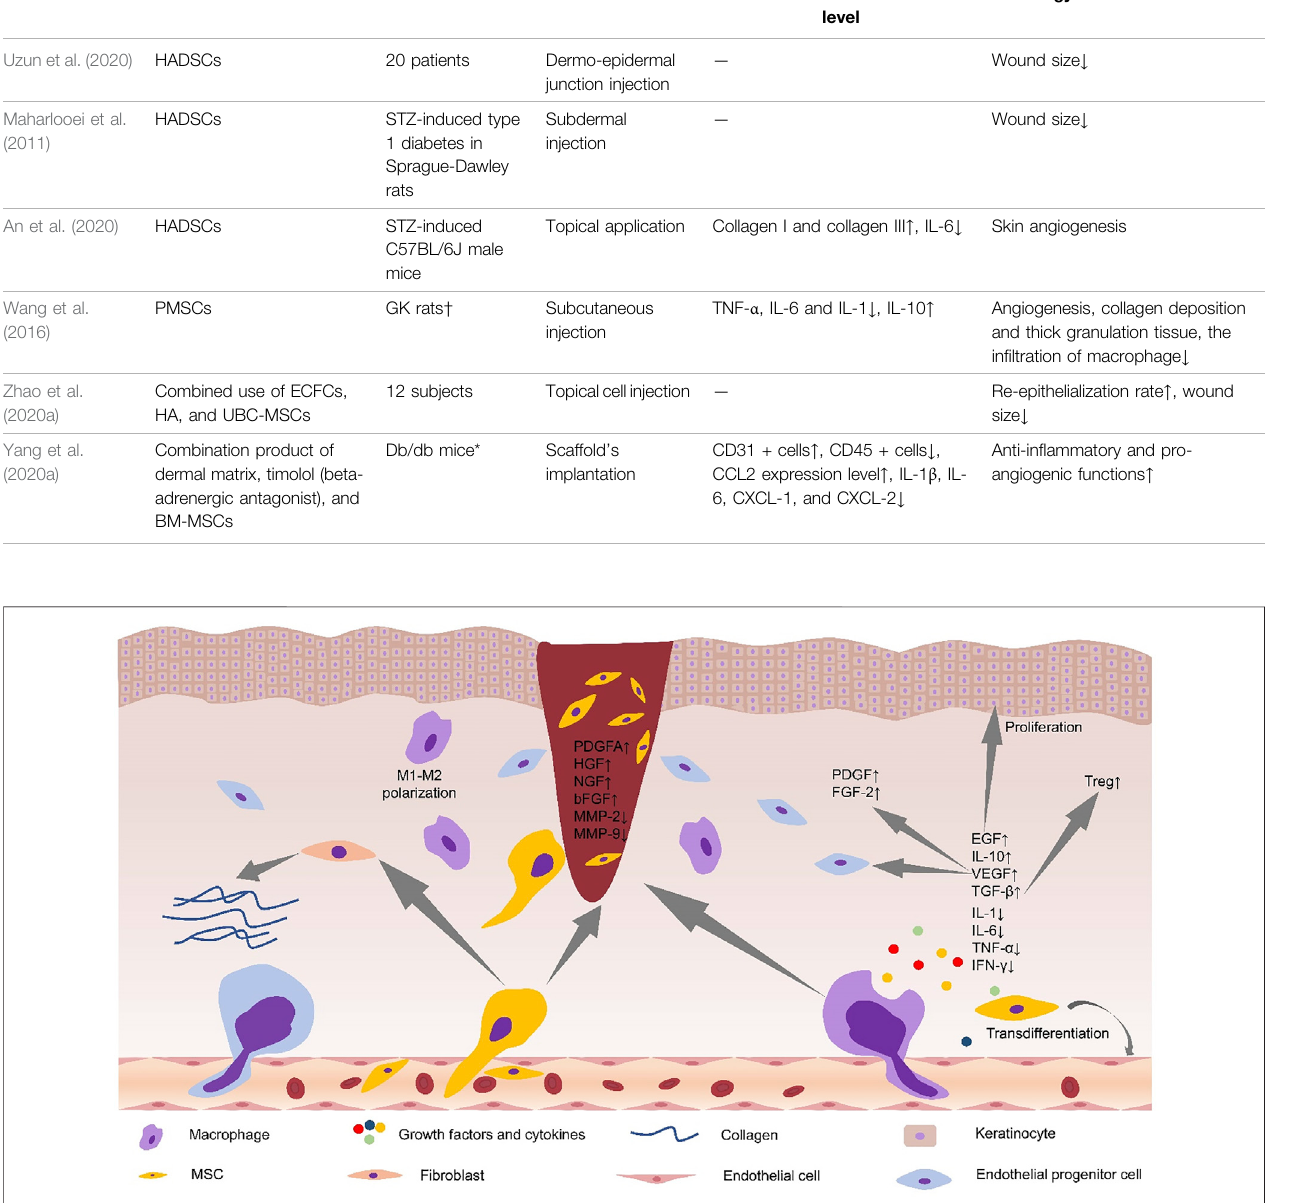
Frontiers in Cell and Developmental Biology |